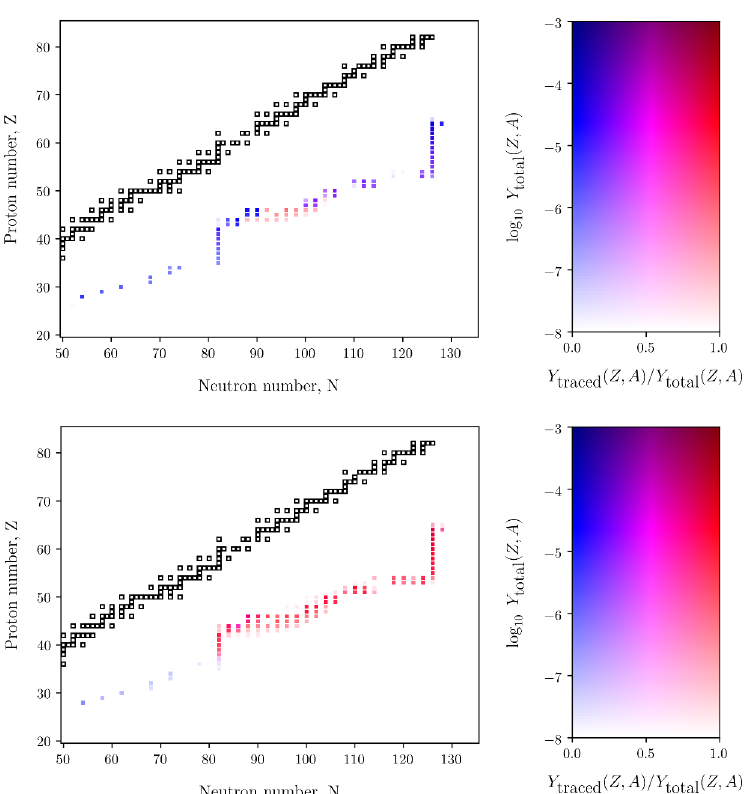
Figure 2. Neutron-induced fission product contributions to nuclear abundances at the onset of fission during nucleosynthesis (top panel) and after an additional ∼ 0 . 2 seconds of nucleosynthesis has taken place (bottom panel). Total abundances ( Y total ) of each nucleus is given by the luminosity of the colored squares, and their hue encodes the relative fraction of traced nuclei to the total ( Y traced / Y total ). In the top panel, nuclei with mass number A ∼ 130 are beginning to be dominated by fission product